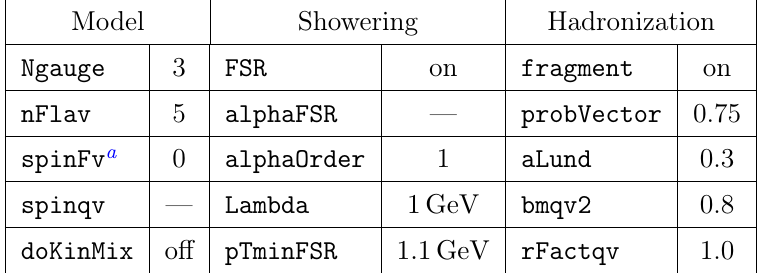
Table 1 . List of variables within the Pythia 8.240 Hidden Valley module, along with the de- fault choices made for the study performed here. All of these variables should be prepended with “ HiddenValley: ” when being called within Pythia . Note that spinqv ( alphaFSR ) are derived from spinFv ( Lambda ), which is why they are marked with “—” in the table. Decay tables for the dark mesons must additionally be